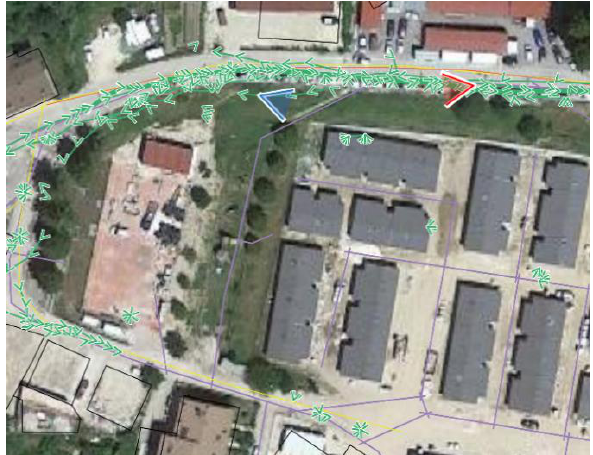
Figure 3. Image orientation and density in Borgo 1,